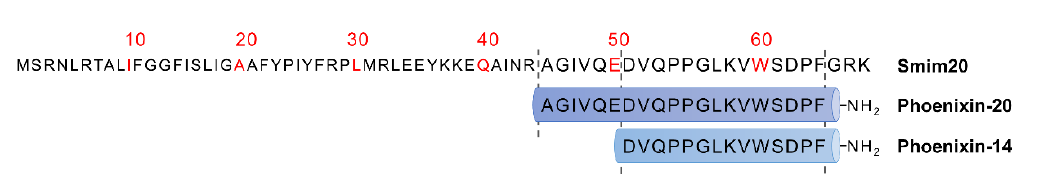
Figure 1. Amino acid sequence of PNX precursor peptide—Smim20 and two main PNX isoforms: PNX-20 and PNX-14.